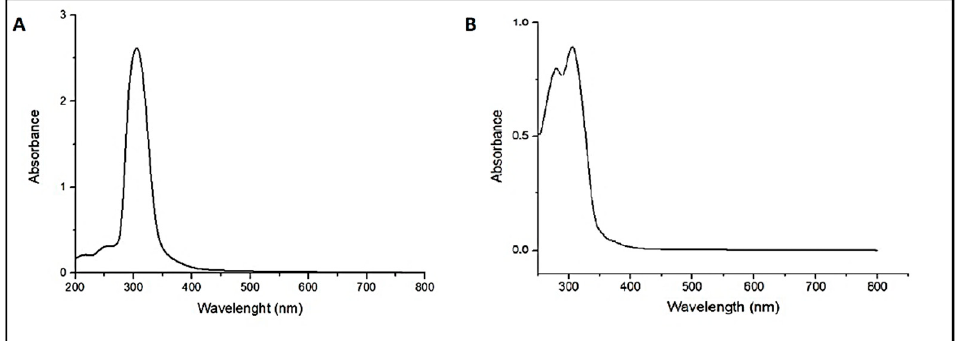
Figure 7. UV-vis spectra of MEM and BLA at the range of 200–800 nm: ( A ) MEM; ( B ) BLA. Table 1. Drug loading capacities of carrier system for BLA and Memantine molecules.